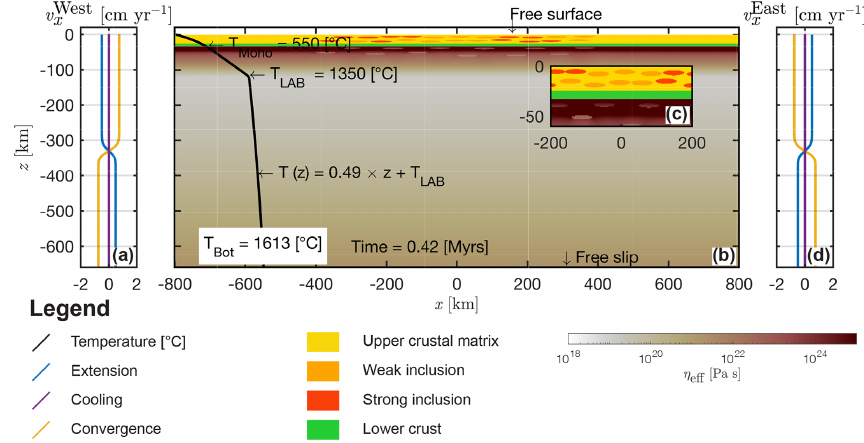
Figure 2. Model configuration and boundary conditions. (a) Profile of horizontal velocity for material inflow and outflow along the western model boundary. The blue line indicates the profile for the extension, the purple line indicates the profile for the cooling and the yellow line indicates the profile for the convergence. (b) Entire model domain. Crustal phases: yellow represents the crustal matrix, dark orange represents strong elliptical inclusions and light orange represents weak elliptical inclusions. White to red shows the effective viscosity field as calculated by the numerical algorithm. All colour maps used to visualize physical fields in this study are provided by Crameri (2018). Black line shows the vertical temperature profile. (c) Enlargement of the central region of the domain. (d) Same profile as shown in (a) , but along the eastern model